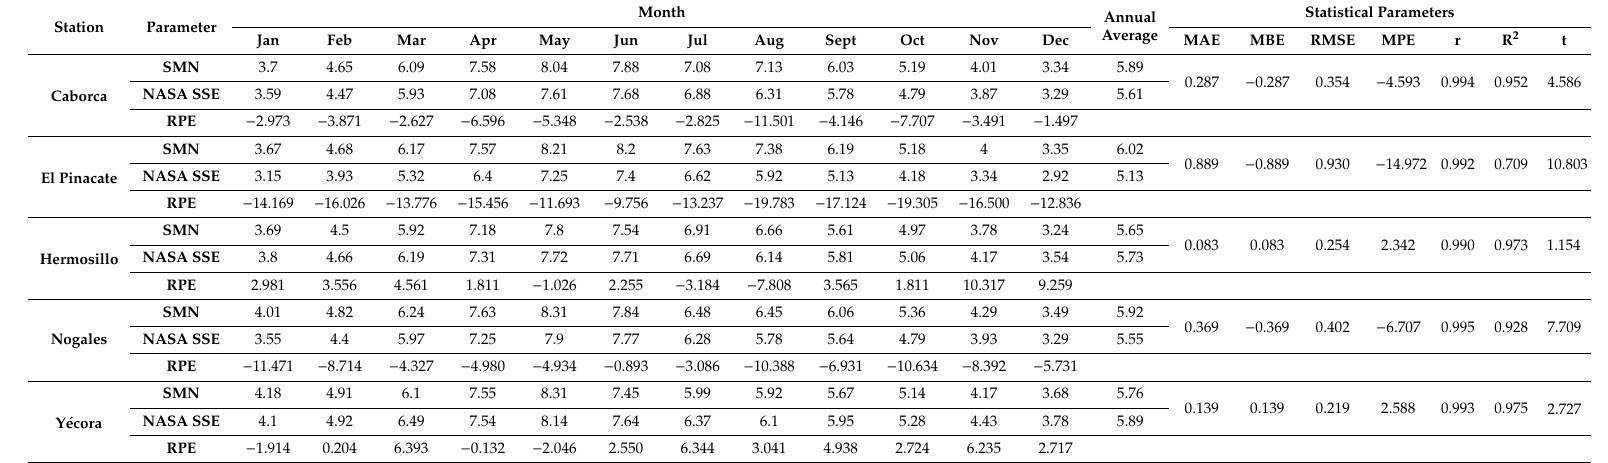
Table 6. Comparison between the SMN and the NASA SSE